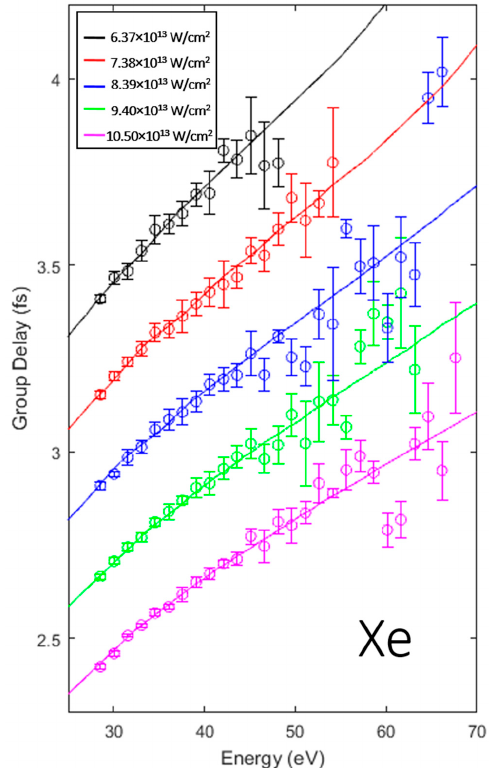
Figure 1. Laser intensity scaling in xenon. Measured extreme ultraviolet (XUV) group delays (circles) are shown from harmonic generation in xenon gas, fitted with intensities as shown in the legend. The lowest-intensity curve was fitted for intensity using Equation (9), and this fitted intensity was scaled according to the measured input power ratio for each additional scan (curves). Each intensity was separated by 0.2 fs for visual clarity.